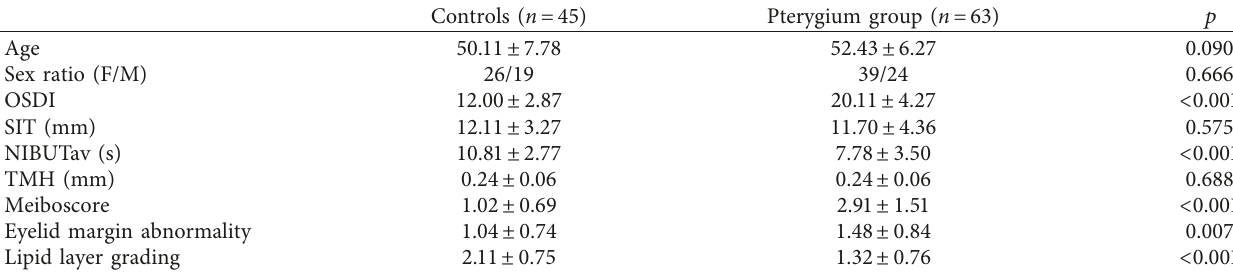
Table 1: Features of ocular surface disorders and MGs in the pterygium patients.